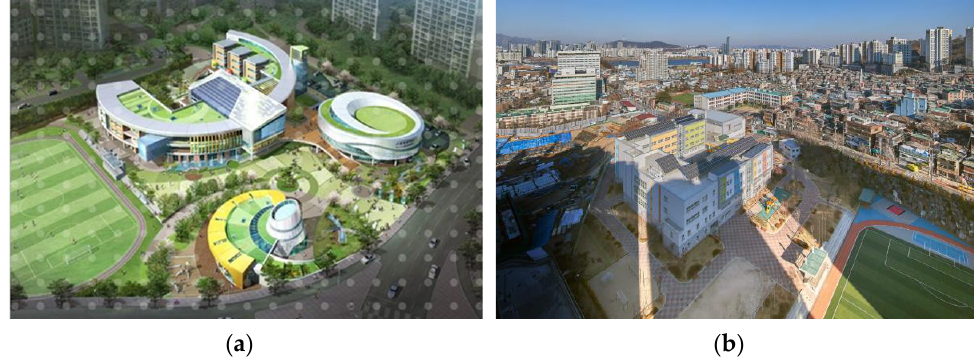
Figure 5. ( a ) Early proposal design by the architect; ( b ) School completed with a design changed through user participation (Source: www.dnbarch.co.kr, accessed on 30 October